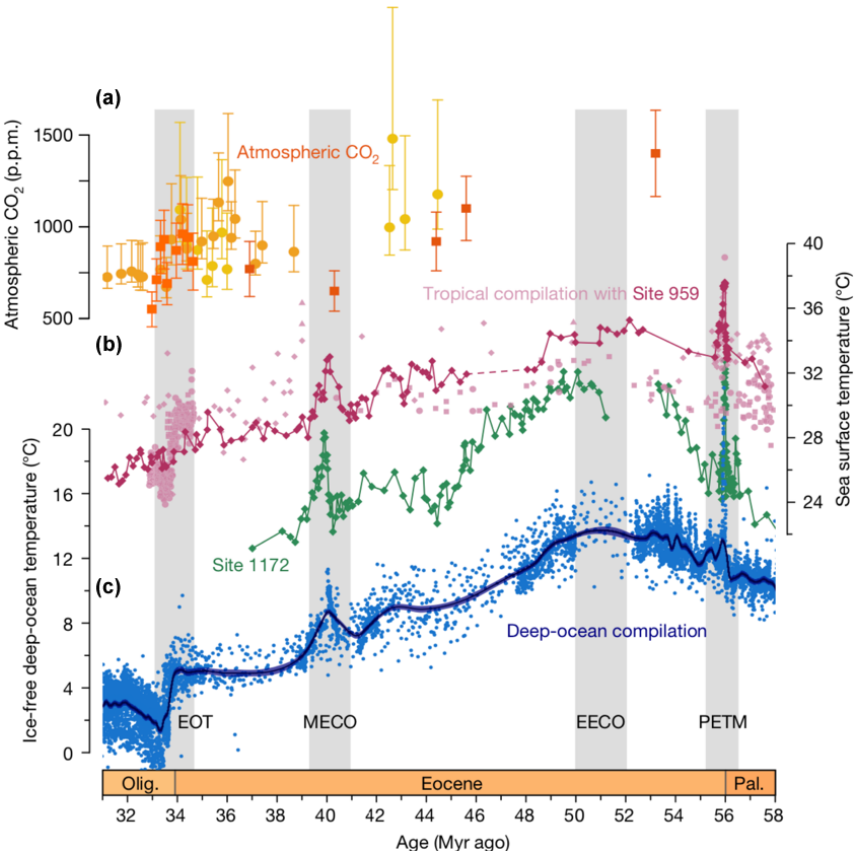
Figure 4. Eocene global climate evolution (redrawn from Cramwinckel et al., 2018). (a) Compiled atmospheric CO 2 based on boron isotope and alkenone stable carbon isotope fractionation data. (b) High-latitude (green) and tropical (purple and pink) sea surface temperature records based on organic (TEX 86 ) and various carbonate-based (Mg / Ca, oxygen isotope, and clumped isotopes) inorganic geochemical proxy data. (c) Ice-free deep-ocean temperature based on high-resolution oxygen isotope data of benthic